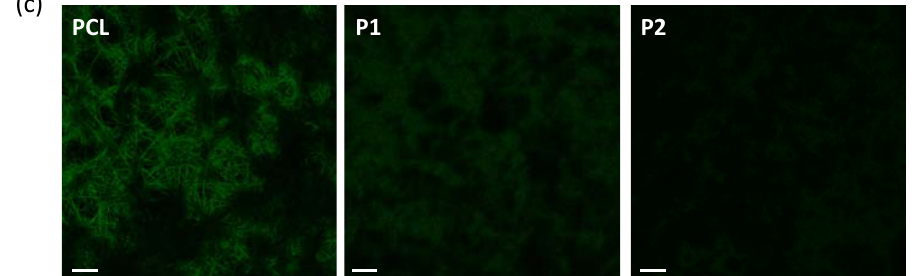
Figure 2. ( a ) Water contact angle images of the PCL , P1 and P2 nanofibers. ( b ) Adsorption of BSA proteins on the surfaces of different nanofibers. ( c ) CLSM images of BSA-FITC adhered on different nanofibers (scale bar is 10 μ m).